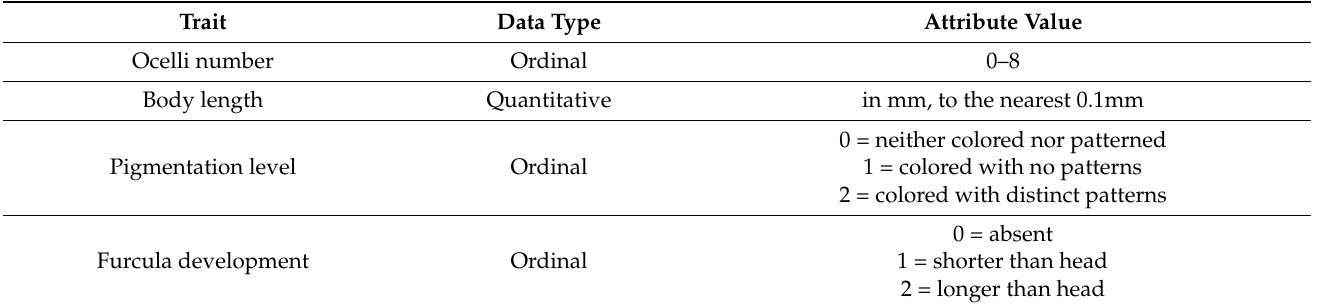
Table 1. Attributes of collembolan